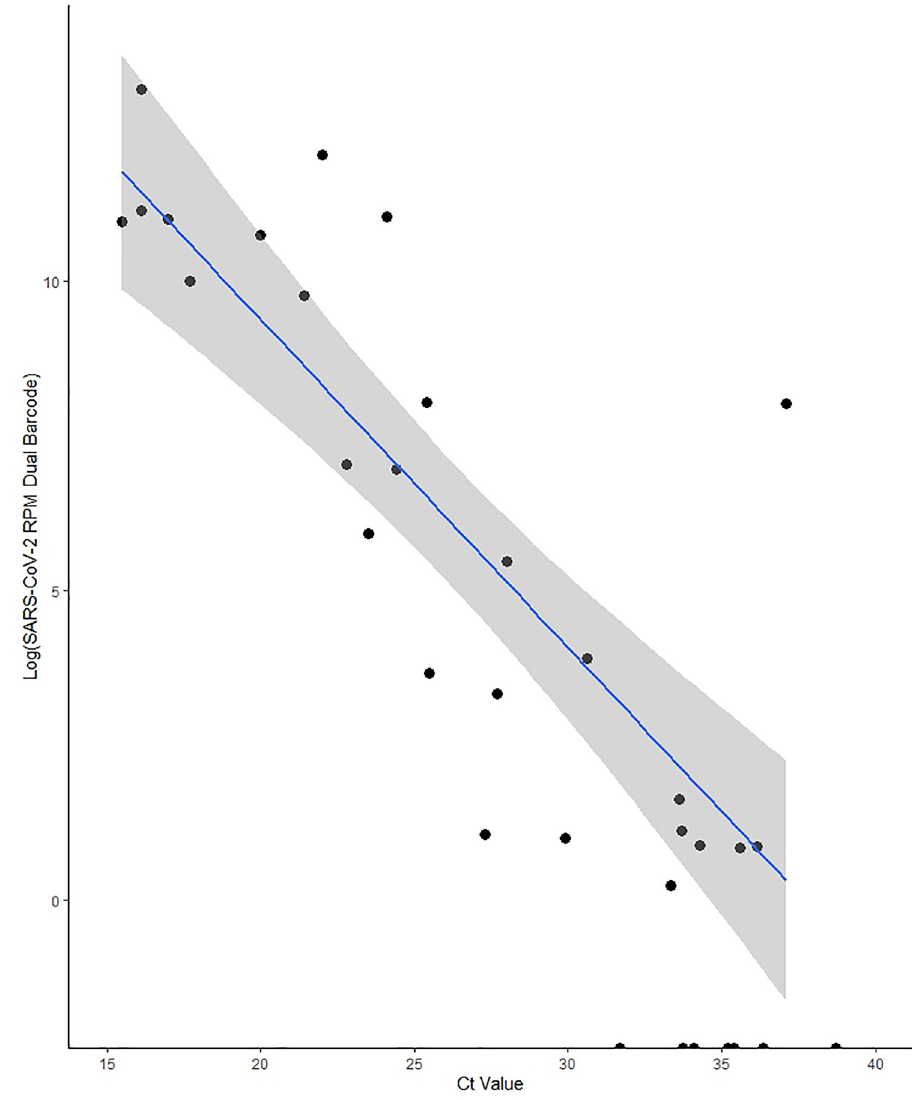
Fig 1. Log SARS-CoV-2 reads per million reads sequenced across C t value (E gene or ORF1ab) for all RT-qPCR positive samples. 95% confidence intervals for the linear regression line are shaded in grey. Coefficient of determination =